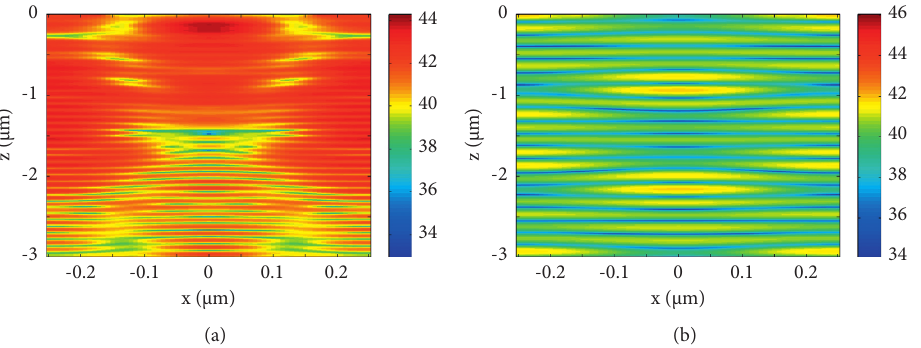
Figure 3: The spatial absorption profiles at 600nm (a) and 1100nm (b).